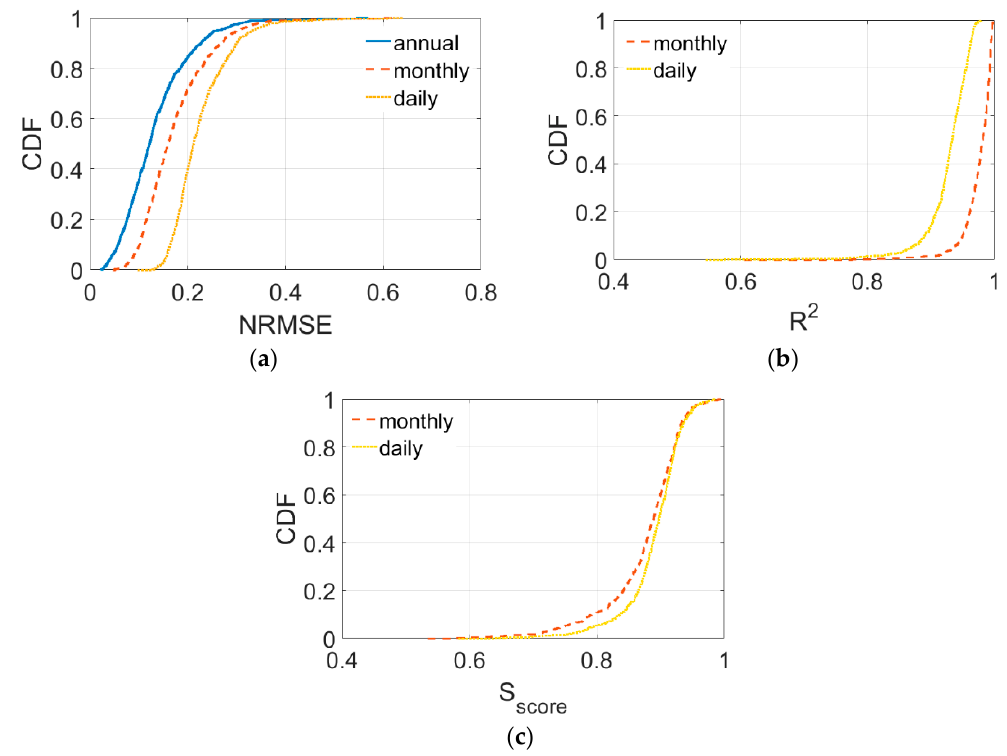
Figure 6. Cumulative distribution functions of the statistical measures NRMSE ( a ), R 2 ( b ), and S score ( c ) indicating the accuracy of monthly and daily PET_cma estimates compared to PET_obs.